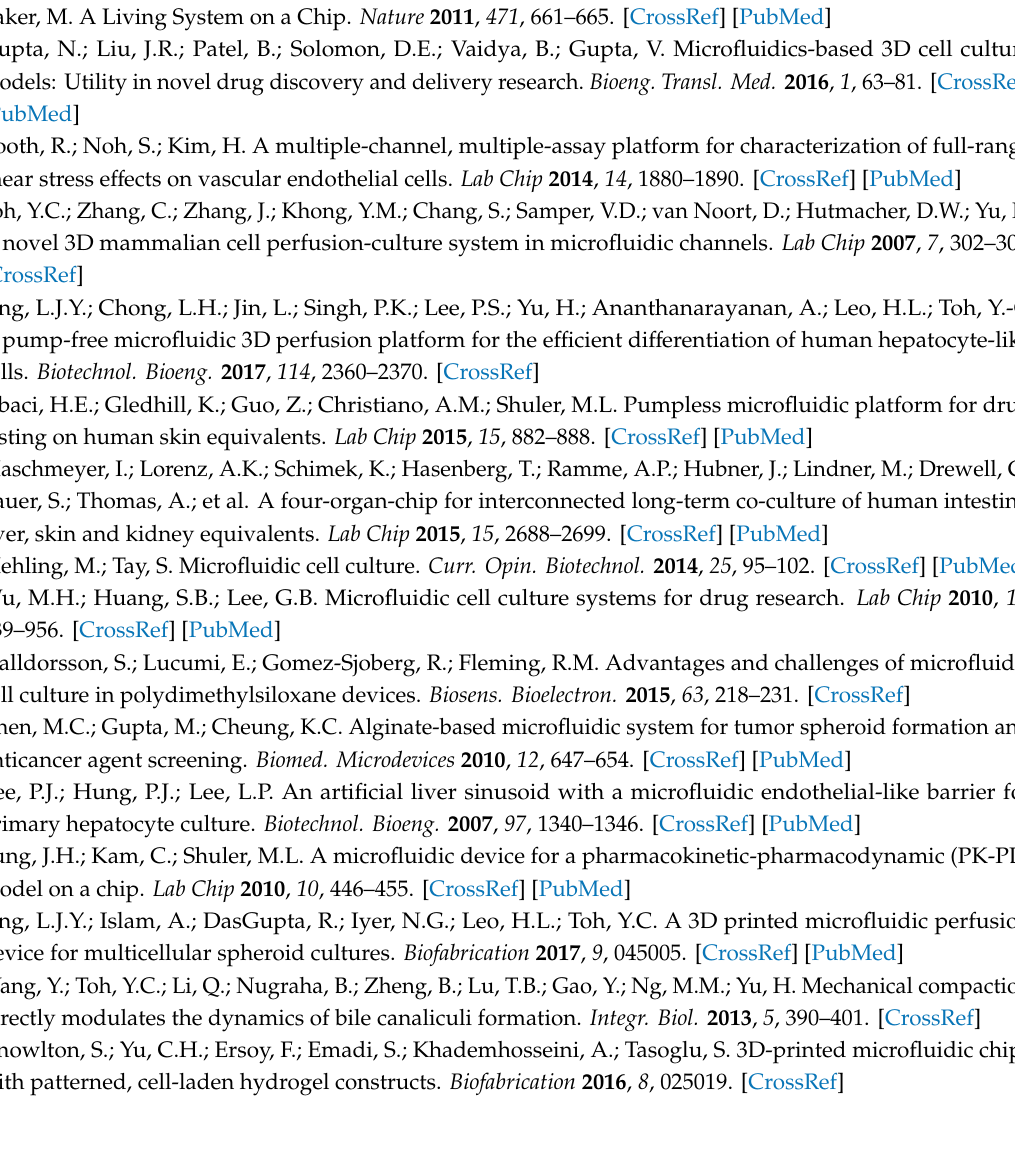
Figure S1: Microfluidic device for the 3D perfusion tissue culture of patient-derived (HN137) OSCCs; Figure S2: Process flow for the silicon mold fabrication process foe the microfluidic cell culture devices; Figure S3: Microfluidic device fabrication flow chart for 3D perfusion tissue culture; Figure S4: Confocal images of Orthogonal projected image of microfluidic 3D culture devices treated with 1.33 stained µ M of gefitinib without collagenase treatment before staining process. Scale bar = 100 µ